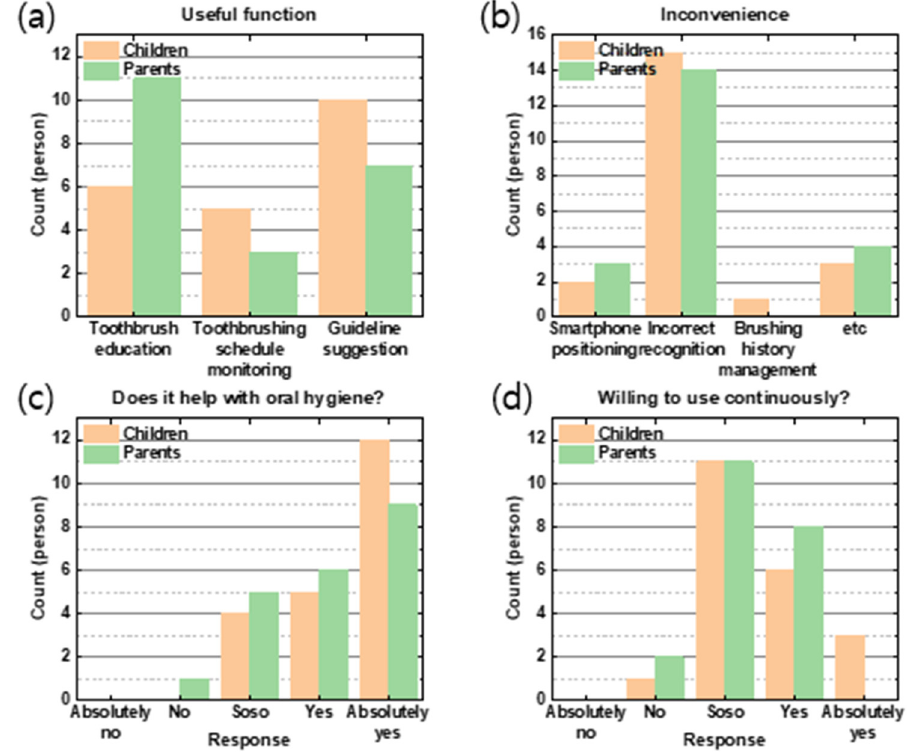
Figure 7. Responses from smart toothbrush users. The orange bar represents children, and the green bar represents parents. The x-axis shows the answers, whereas the y-axis shows the counts of the persons. The following questions were asked: ( a ) “What are the useful functions of ST?”, ( b ) “What are the inconveniences associated with using ST?”, ( c ) “Does ST help with oral hygiene?”, and ( d ) “Are you willing to use ST